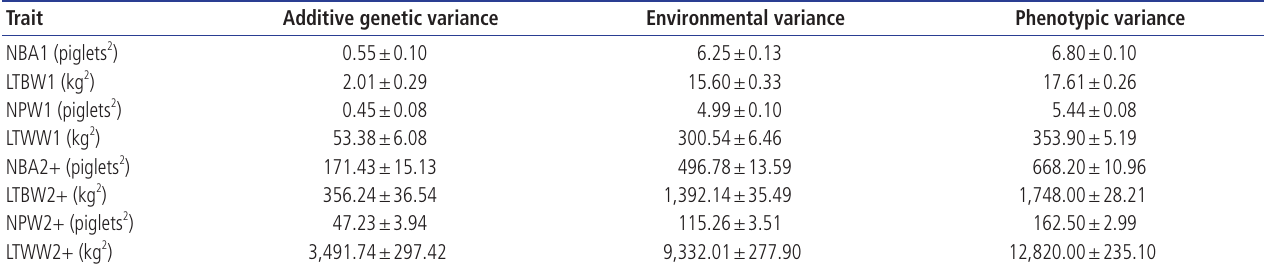
Table 3. Estimates of additive genetic, environmental, and phenotypic variances for first parity and sums from second to last parity reproduction traits Trait Additive genetic variance